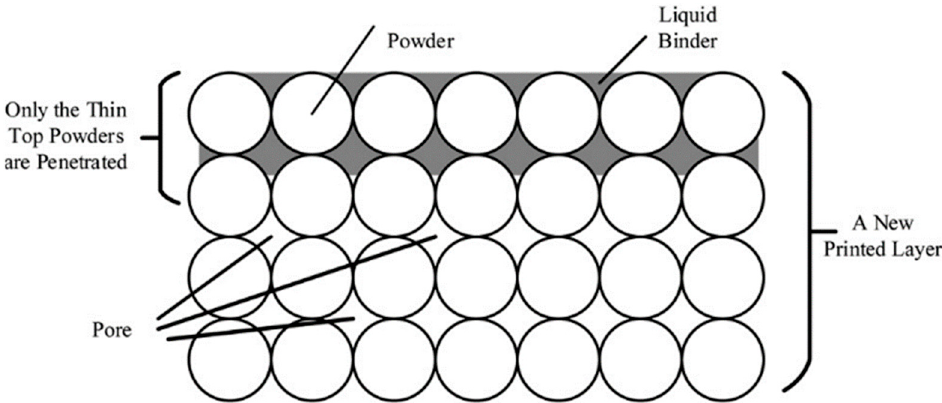
Figure 9. Short drying time results in inadequate binder penetration [15] .